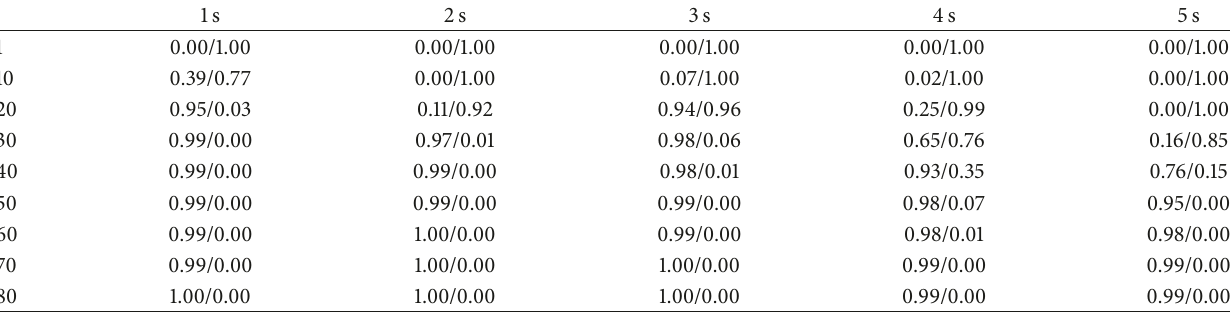
Table 2: FN and FP for the Euclidean distance.